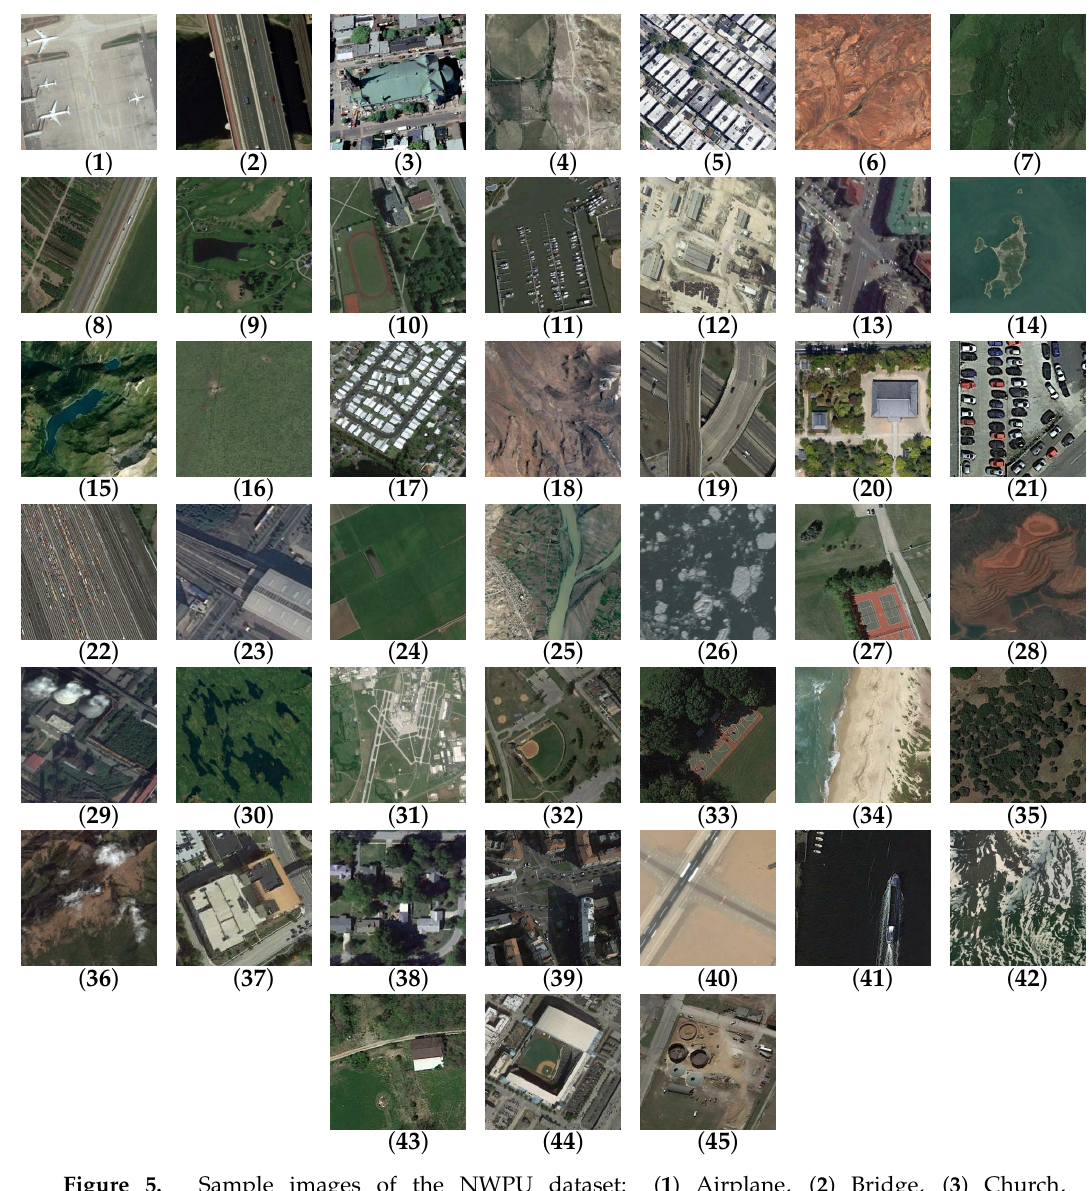
Figure 5. Sample images of the NWPU